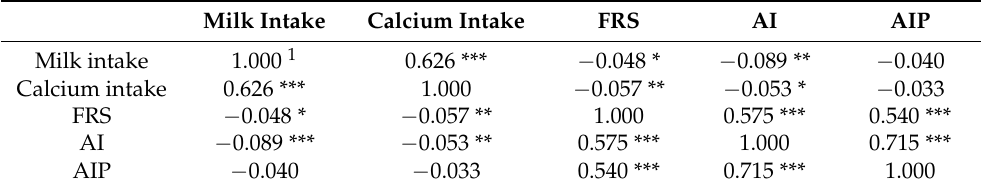
Table 6. Correlations among milk intake, calcium intake, and indicators of CHD